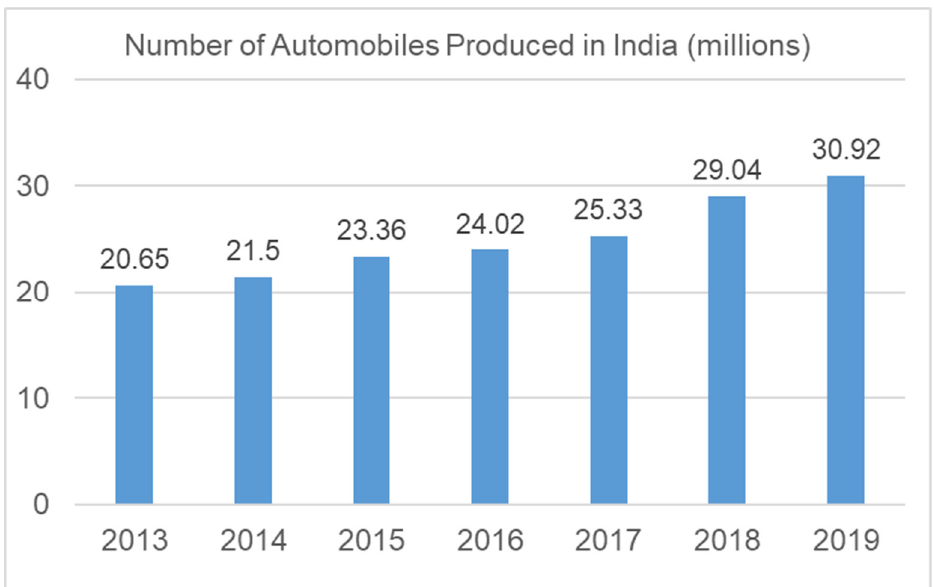
Figure 1. Number of Automobiles Produced in India from 2013 to 2019.